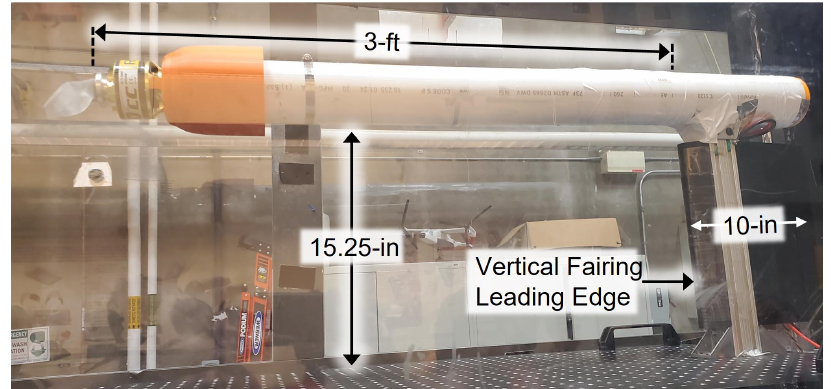
Figure 9. Dynamometer dimensions in the wind